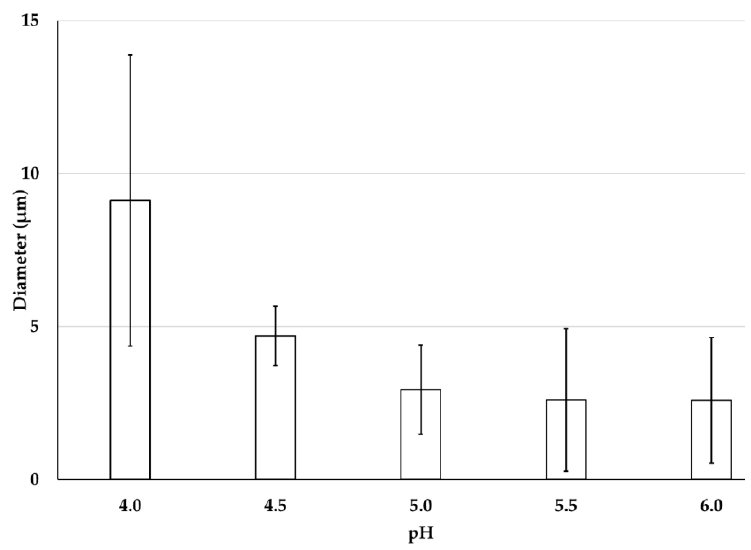
Figure 4. Mean diameter of CH‐based Emulsion‐1 at pH from 4.0 to 6.0. Mean values with 95% confidence interval.